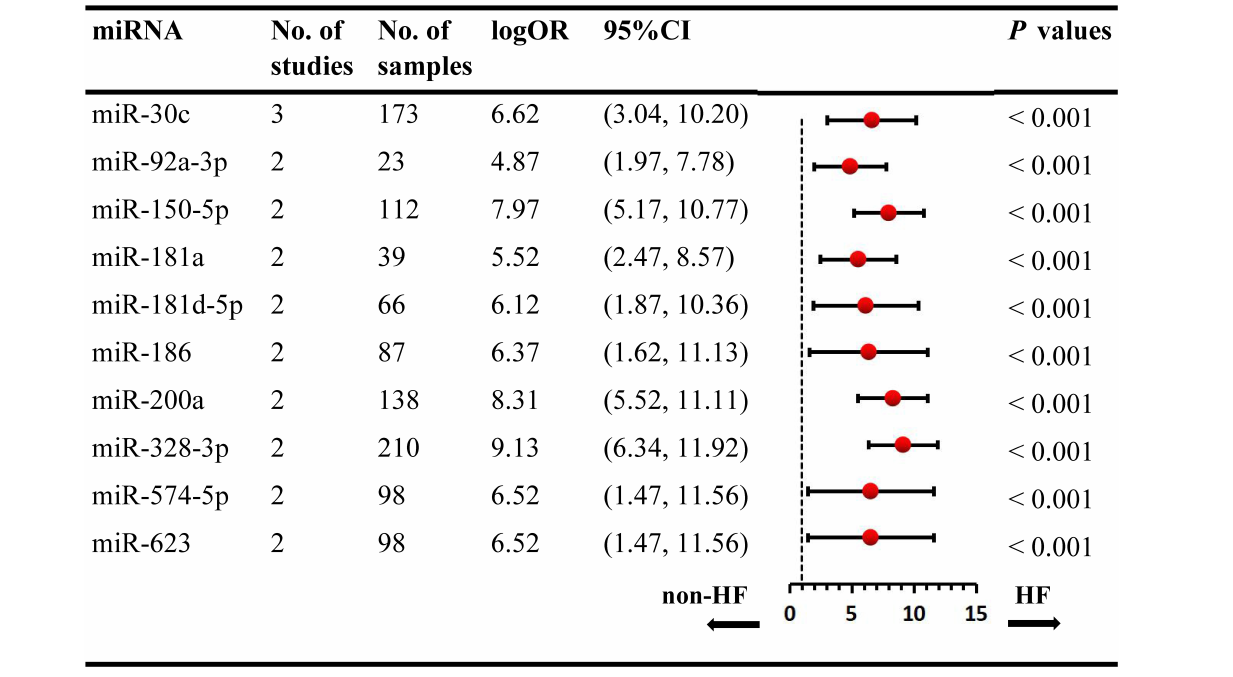
(logOR 8.02; 95% CI: 6.76–9.27, P < 0.001) and with miR-328- 3p (logOR 9.13; 95% CI: 6.34–11.92, P < 0.001) being the